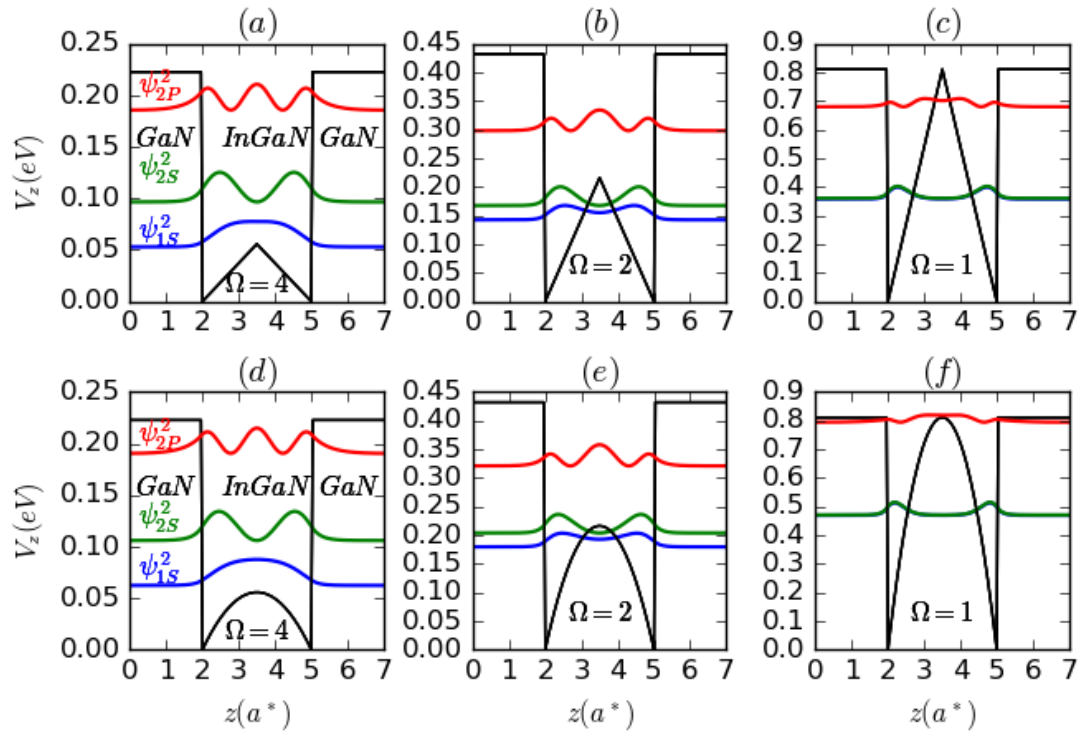
Figure 1: The confinement potential profile as well as the square of the three low-laying electron wave-functions versus z-axis for three different values of Ω(x )=4(2,1) for two QW’s shapes c ITQW and